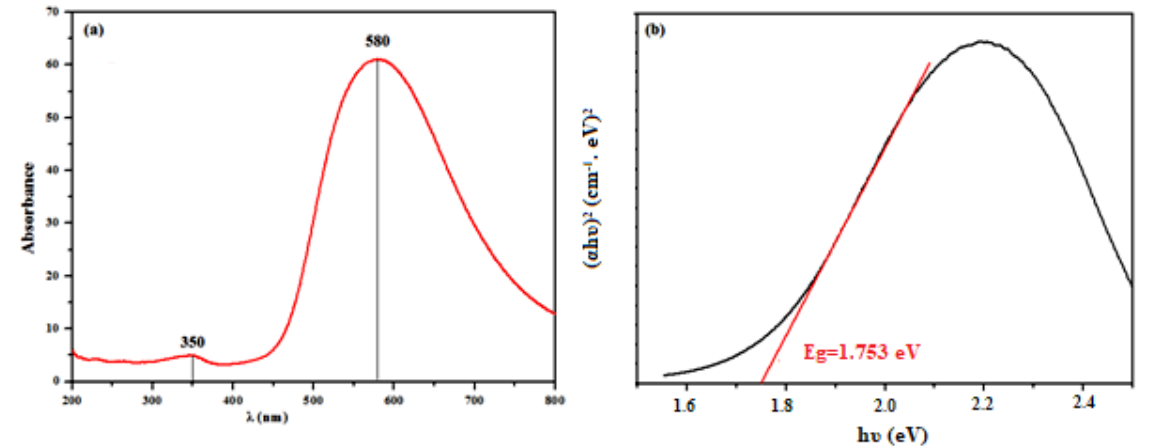
Figure 9. The solid-state UV-Visible spectrum at room temperatureof (C 9 H 14 N) 2 [CuCl 4 ] ( a ). Tauc’s plot giving the energy gap ( b ).